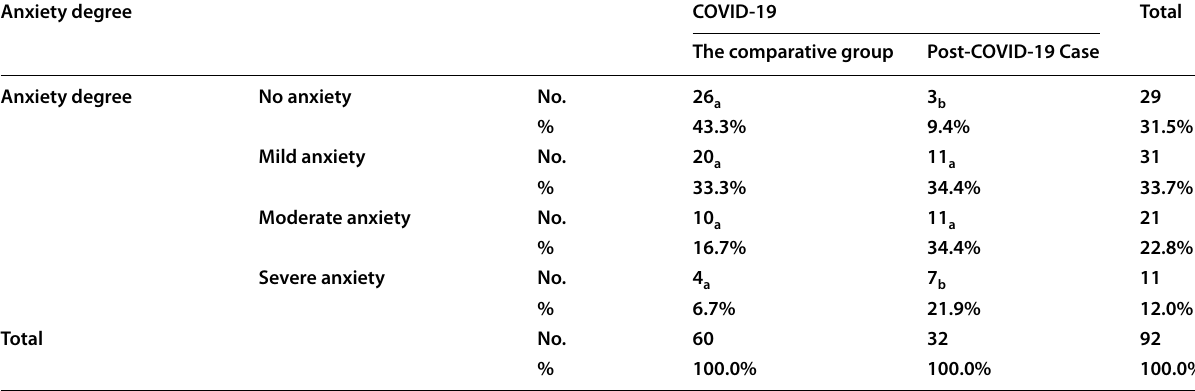
Exact Pearson chi-square